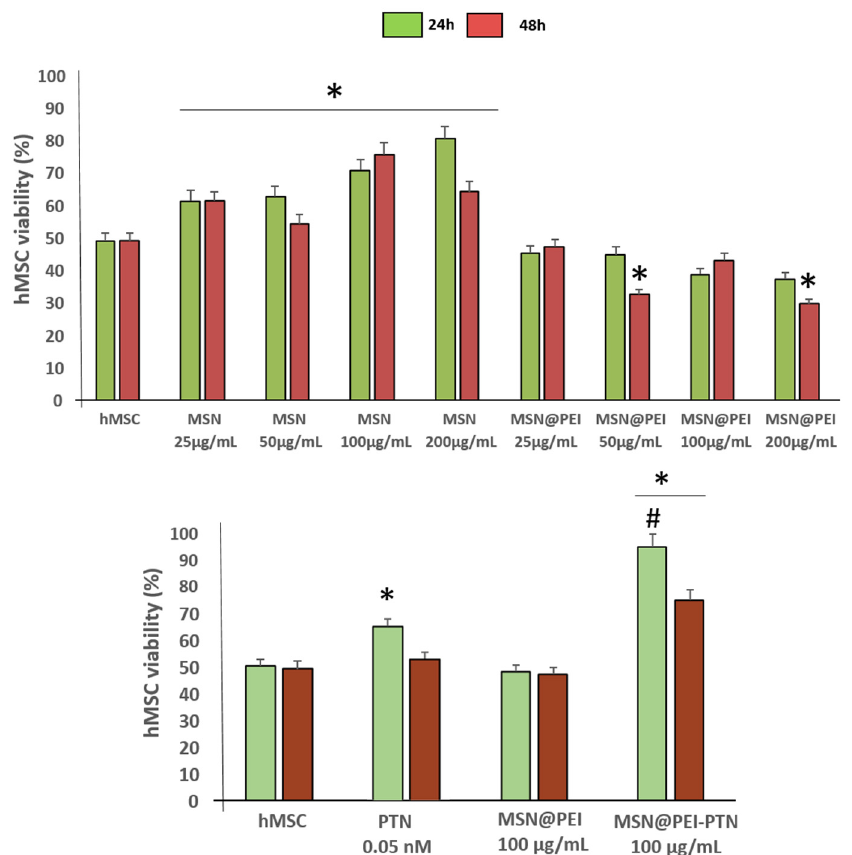
Figure 7. Human Mesenchymal Stem Cell (hMSC) viability (measured by Alamar Blue ® ) in contact with different concentrations of MSN and MSN@PEI loaded or not with pleiotrophin (PTN) or in the presence of 0.05 nM exogenous PTN alone at 24 and 48 h of cell culture. Data are mean ± SEM of three independent experiments performed in triplicate. * p < 0.05 vs. hMSC and MSN@PEI 100 µ g/mL; # p < 0.01 vs. PTN 0.05 nM and all